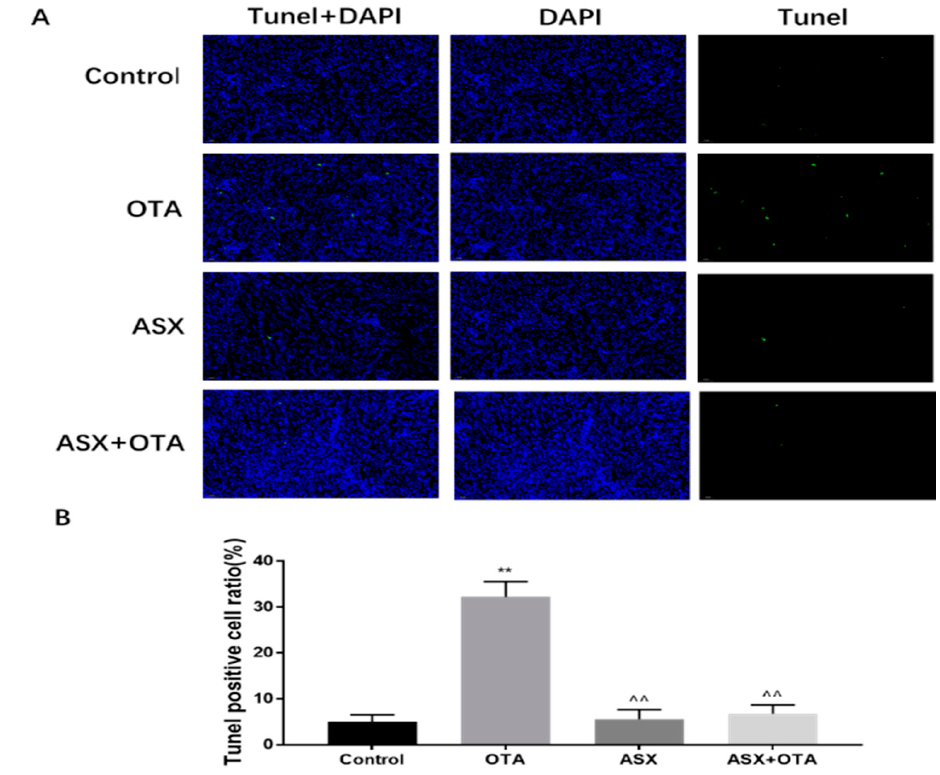
Figure 4. Apoptosis analysis. ( A ) Renal terminal deoxynucleotidyl transferase nick-end-labeling